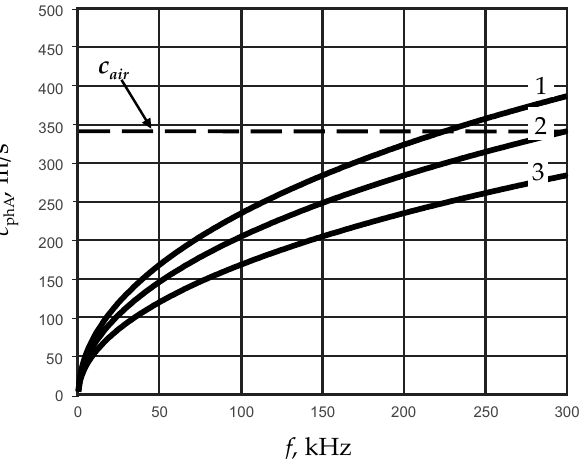
Figure 3. Phase velocities of A 0 mode in PVC films of different thickness: 1— d = 200 µ m, 2— d = 150 µ m, 3— d = 100 µ m.